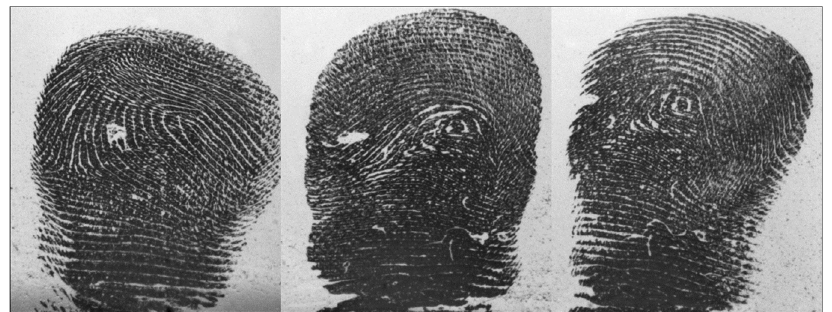
Figure 3. Sequential FTIR images of a single infant finger showing collapse of features and distortion of minutiae